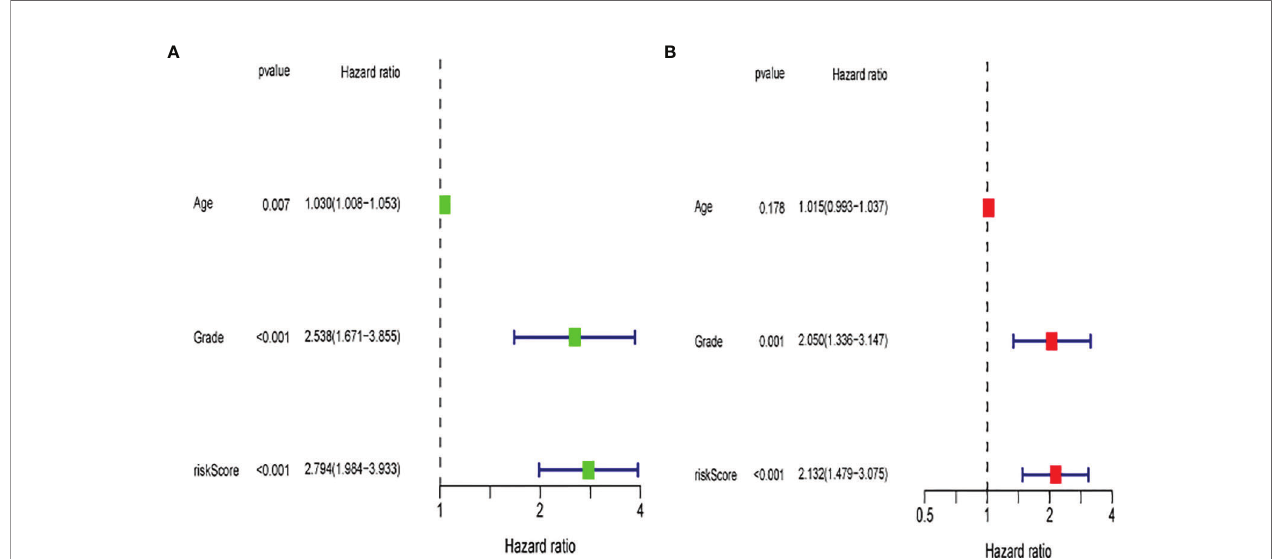
FIGURE 12 | Evaluation of the prognostic risk model. ( A ) Univariate Cox regression analysis for the risk score. ( B ) Multivariate analysis for the risk